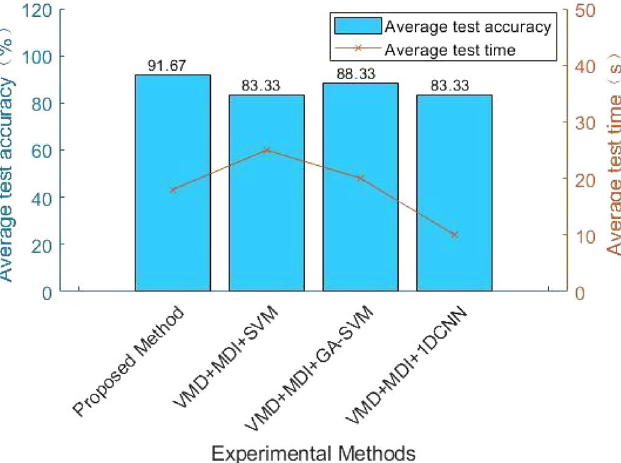
Figure 11. Comparison of different fault classification methods.